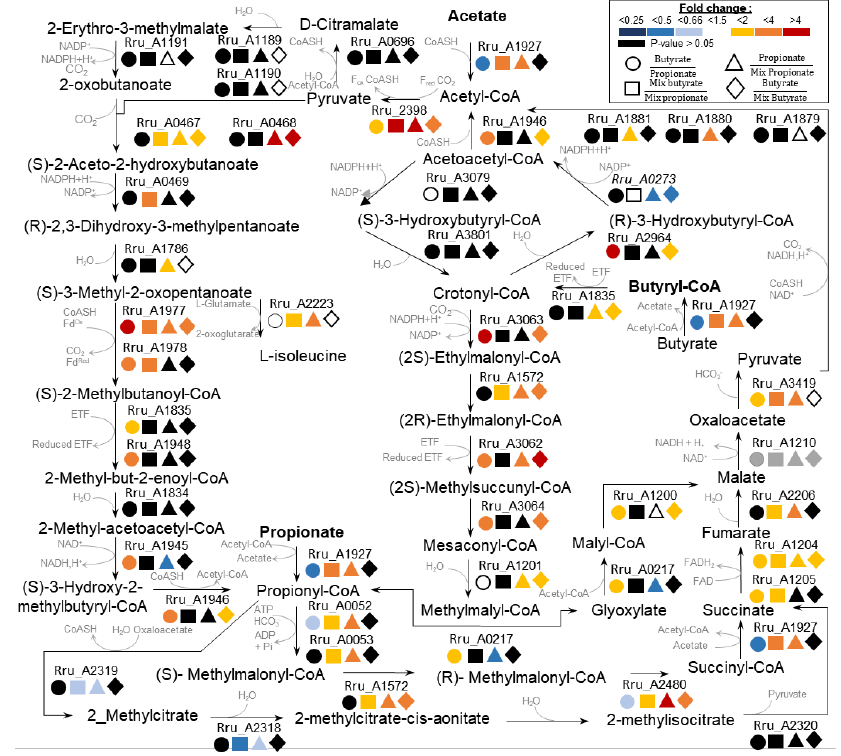
Figure 3. Schematic representation of the metabolic pathways highlighted through differential proteomic analysis (n = 5). The different colors indicate the fold changes: white, biologically non-relevant fold change (fold change value between 0.66 and 1.5); black, fold change not significant ( p -value > 0.05); grey, protein not identified.